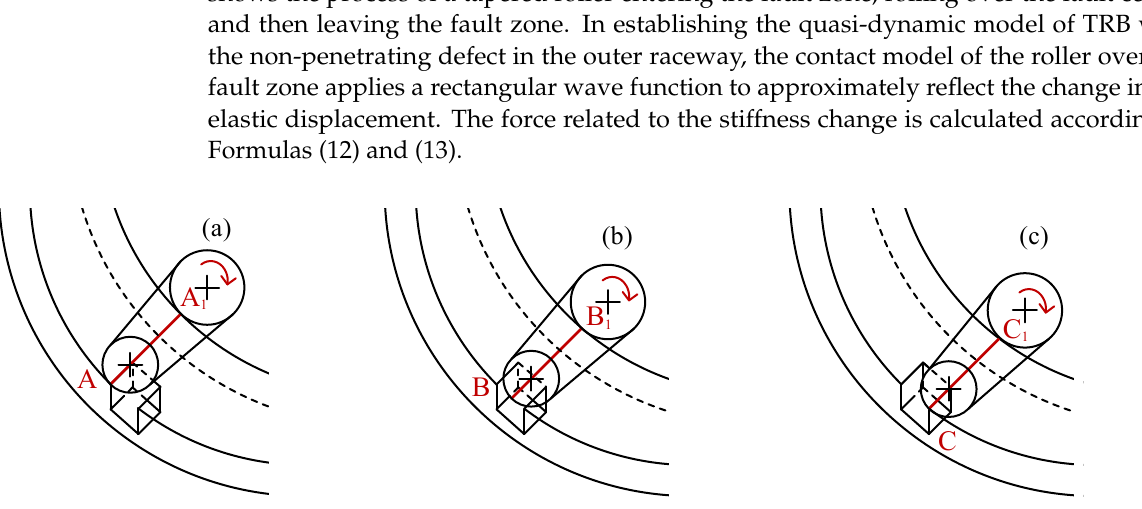
Figure 4. Schematic diagram of TRB with non-penetrating damage.